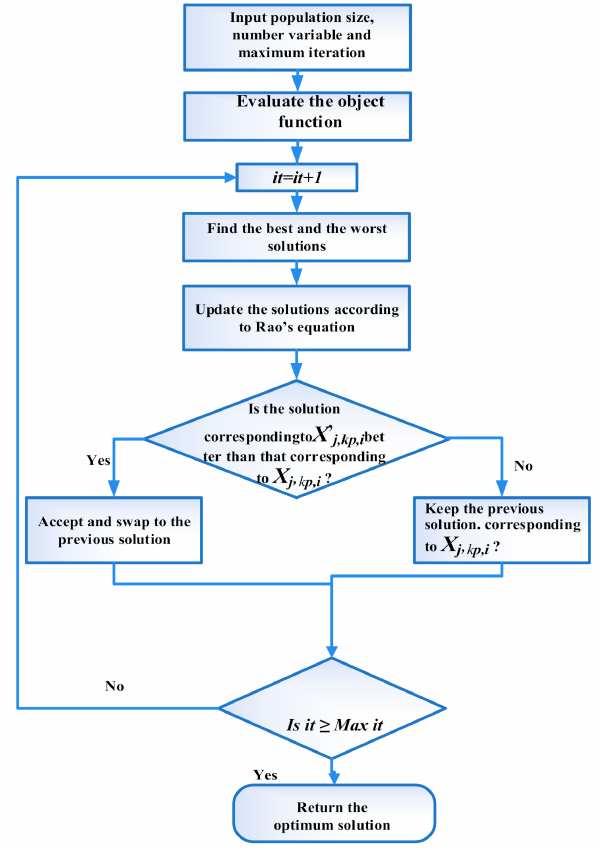
Figure 1. Flowchart of Rao-2